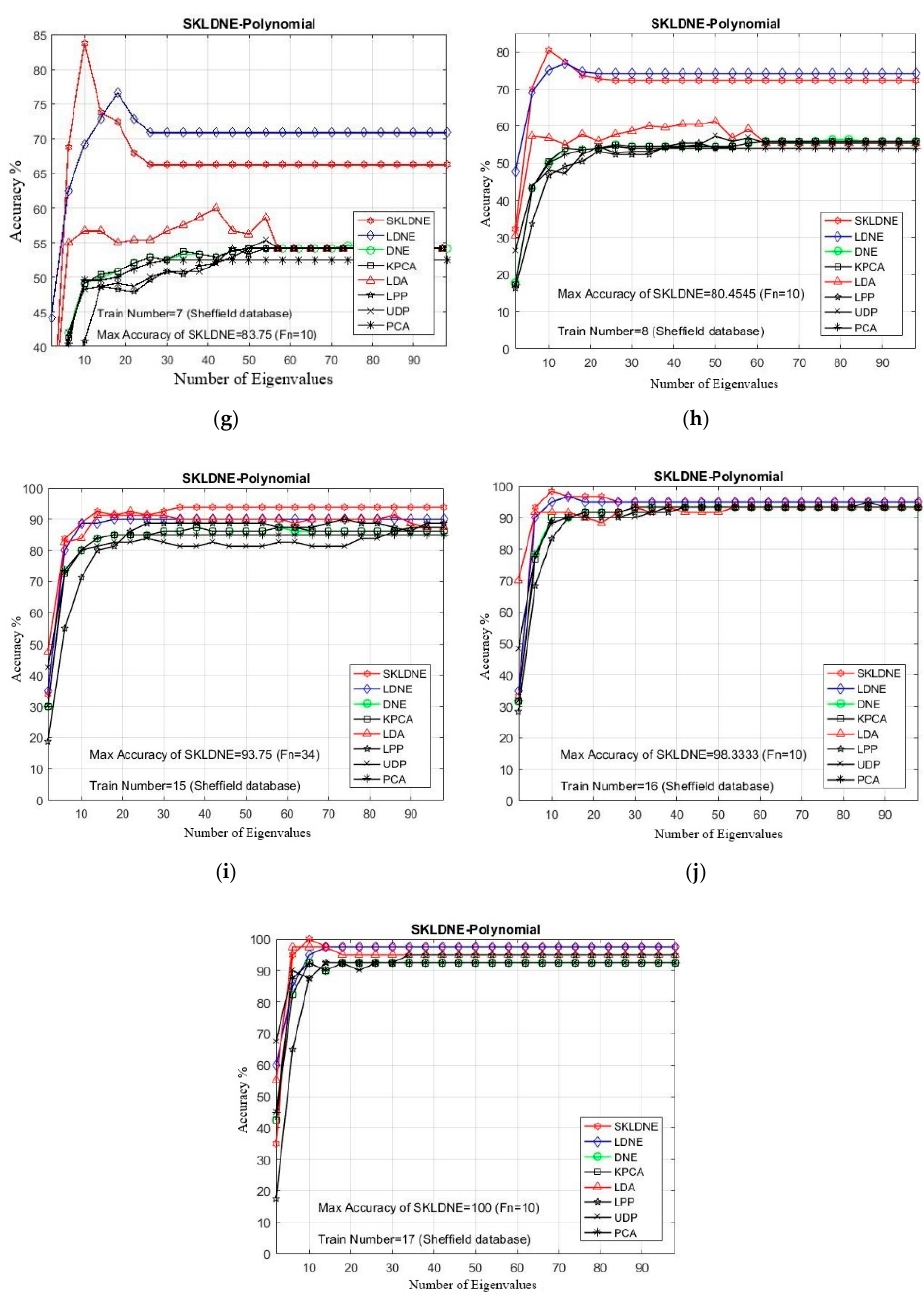
Figure 3. ( a – k ) The comparative recognition results changing the dimensionality of the transformation matrix for each given training number Tn on each data (Sheffield Face database).